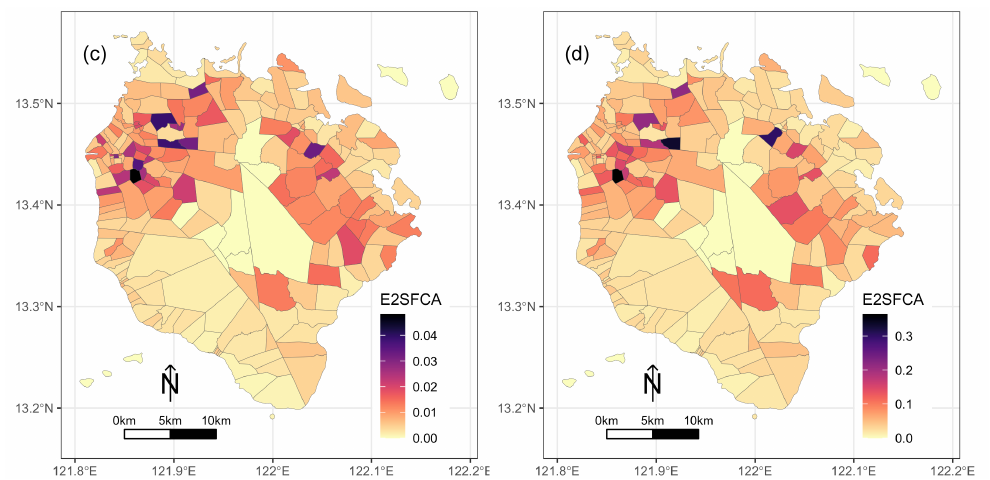
Figure 7. Accessibility scores of different population groups in the province of Marinduque: ( a ) gen- eral population; ( b ) children; ( c ) women; and ( d )